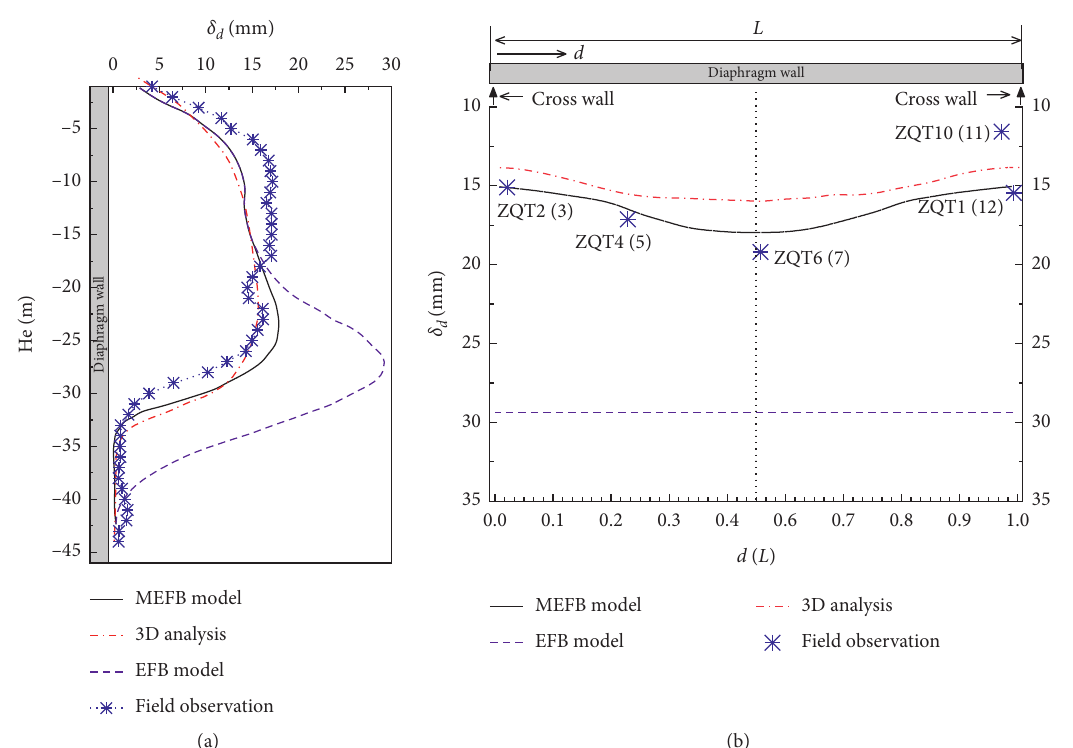
Figure 15: Comparison of the computed maximum lateral wall deflections at various sections and those from field observation for YDM. (a) Wall deflection at ZTQ-6. (b) Wall deformations at GL-26.0m in various cross-sections